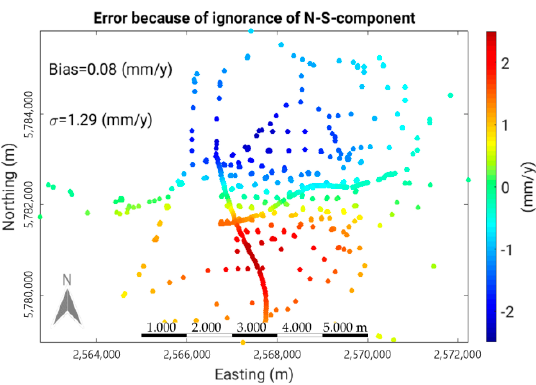
Figure 10. Error of vertical displacement because of ignorance of north-south component.